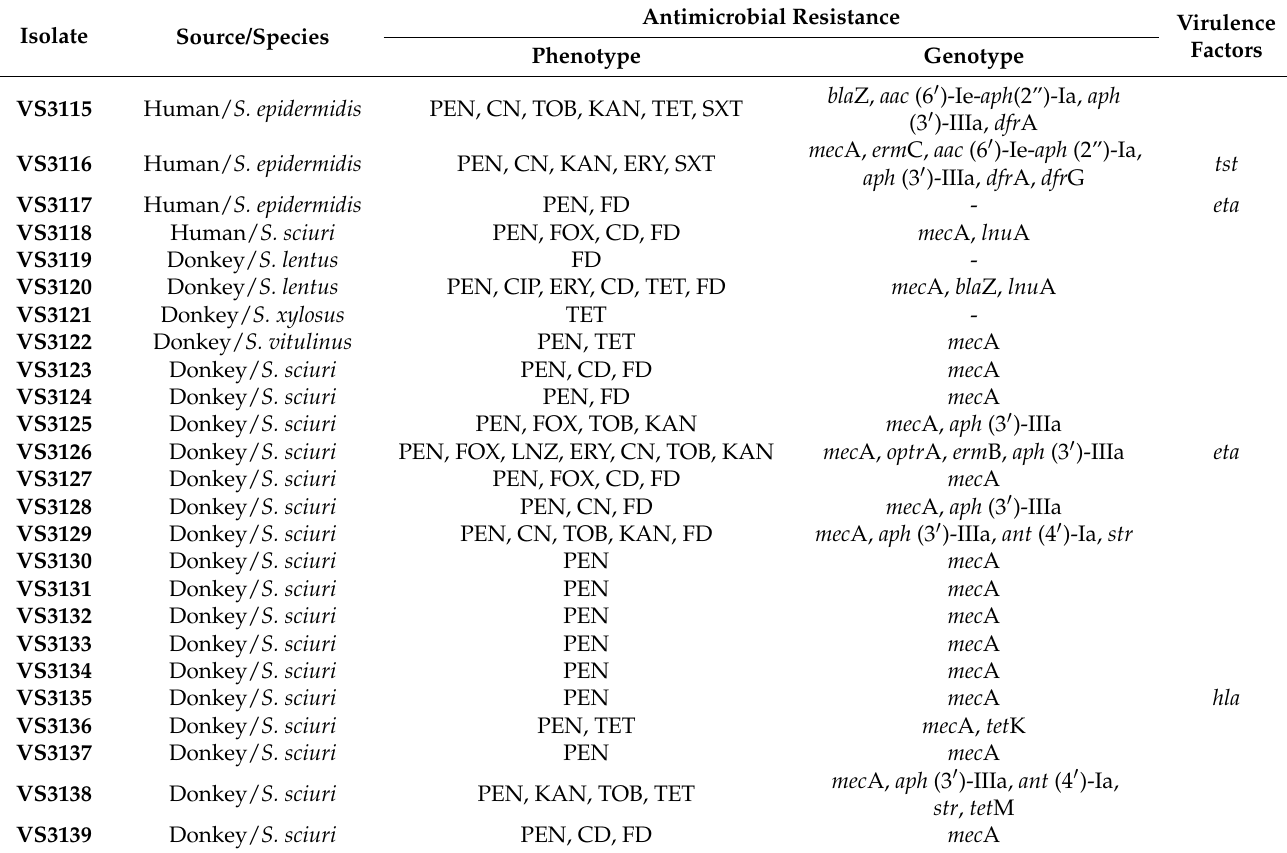
Table 2. Diversity, antimicrobial resistance and virulence of CoNS isolated from donkeys and handlers. Antimicrobial Resistance Virulence Source/Species FactorsPhenotype